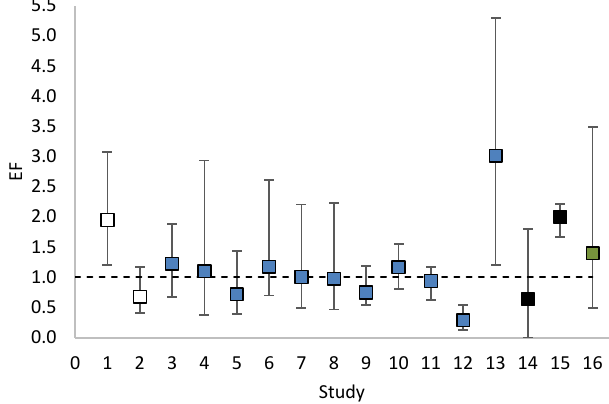
Figure 1. Mean enrichment factors (EFs) for DMS in the SSM re- ported in previous studies. The upper and lower bars indicate the highest and lowest values reported in each study. An EF of 1.0, shown by the horizontal dashed line, indicates no difference be- tween [DMS SSM ] and [DMS SSSW ], with EF >1 denoting enrich- ment in the SSM relative to SSSW, and values <1 a deficit relative to SSSW. The sampling method is indicated by the symbol colour: plate (white), mesh (blue), drum (black), and cryogenic (green). References: 1 (Yang, 1999); 2 and 3 (Yang et al., 2001); 4 (Yang and Tsunogai, 2005); 5 (Yang et al., 2005a); 6 (Yang et al., 2005b); 7 (Yang et al., 2006); 8 (Zhang et al., 2008); 9 (Yang et al., 2008); 10 and 11 (Zhang et al., 2009); 12 (Yang et al., 2009); 13 (Matrai et al., 2008); 14 (Zemmelink et al., 2006); 15 (Turner and Liss, 1985); and 16 (Nguyen et al.,